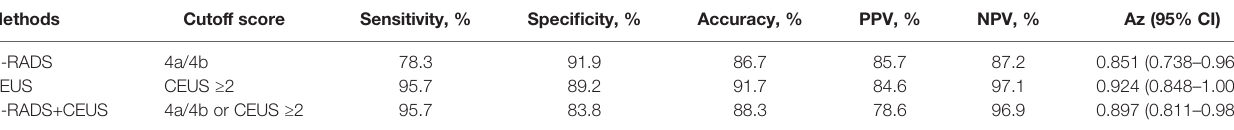
TABLE 4 | Diagnostic performance for discrimination between PCPTCs and nodular goiters.